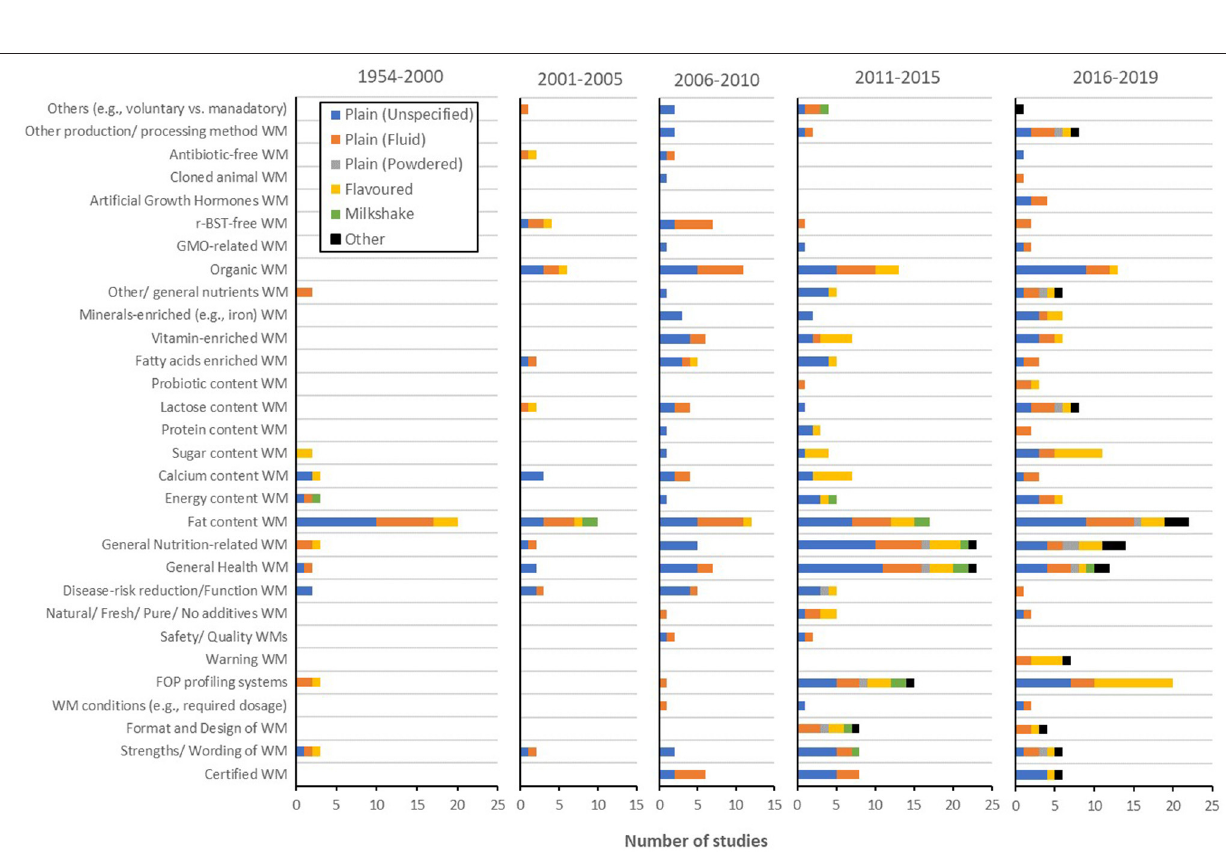
FIGURE 9 | Prevalence of message-related empirical studies for each milk type [i.e., plain (unspecified), plain (fluid), plain (powdered), flavoured milk, milkshake, and other milk drinks] during each period (i.e., 1954–2000, 2001–2005, 2006–2010, 2011–2015, and 2016–2019). WM, well-being messaging; FOP, front-of-pack; r-BST, recombinant bovine somatotropin; GMO, genetically